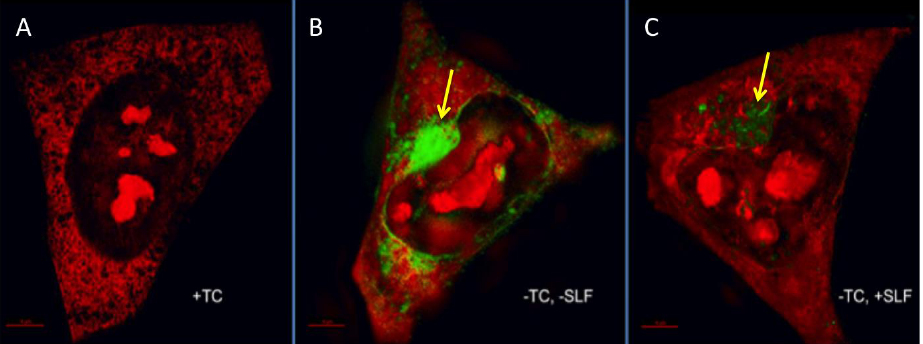
Figure 7. Super-resolution structured illumination (SIM) images of intraneuronal Aβ stained with the amyloid dye FSB (green). In all images, MC65 neuronal cells were stained with propidium iodide (red). No FSB signal is observed for cells grown in the absence of APP induction (+TC, panel A ). For cells induced for APP expression, a large intracellular Aβ accumulation is apparent (green signal, panel B ), which leads to a distortion of the nuclear membrane (yellow arrow). When SLF is included in the APP-induced MC65 culture, the Aβ stain signal is greatly reduced ( C ). Scale bar represents 1 μm.